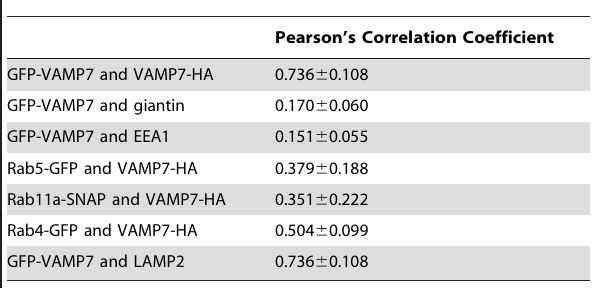
Table 1. Colocalization of VAMP7 with organelle markers.